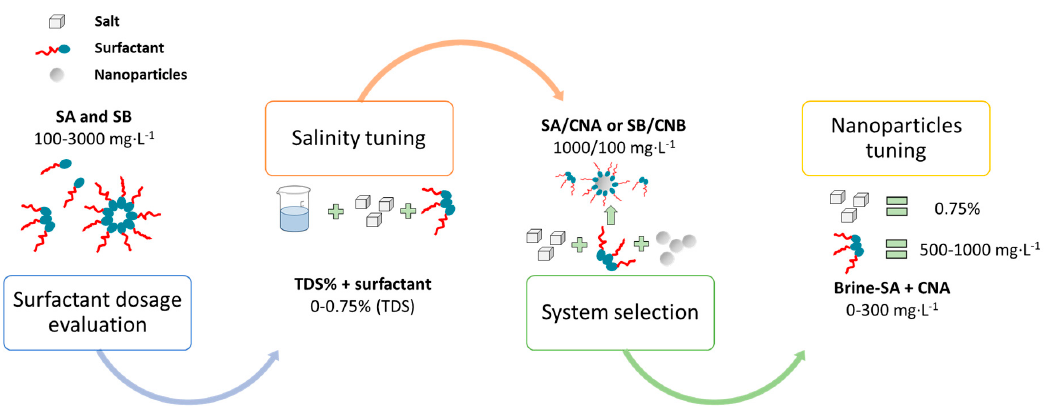
Figure 1. Surfactant–nanoparticle–brine tuning scheme.